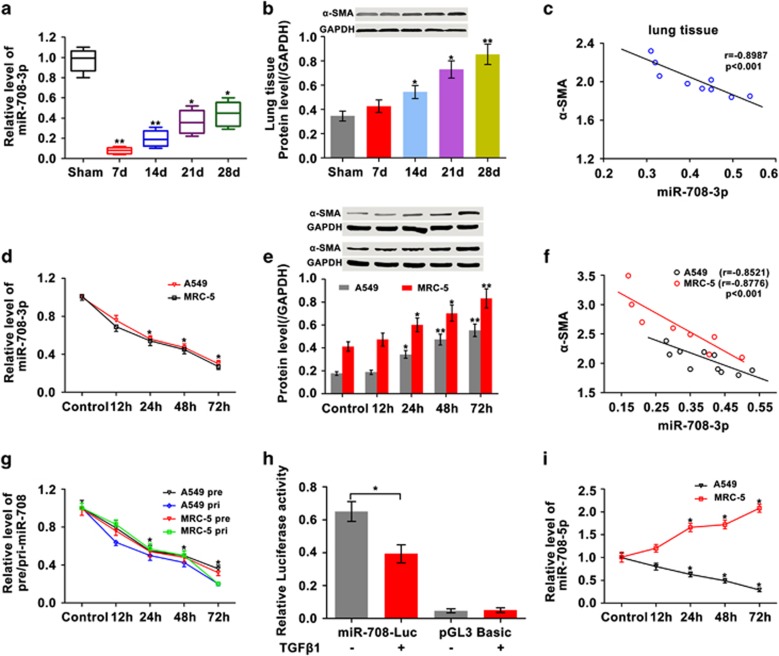
MiR-708-3p expression decreased during fibrosis in vivo and in vitro. (a) MiR-708-3p expression diminished in the lung tissues treated with BLM for 0, 7, 14, 21 and 28 days, as indicated by qRT-PCR. The miR-708-3p expression was normalized to the sham group. (b) α-SMA expression increased in the BLM group relative to that in the sham group. (c) Pearson correlation coefficient clarified that miR-708-3p inversely correlated with α-SMA in vivo. (d) The qRT-PCR results showed that miR-708-3p expression decreased in the TGF-β1-treated A549 and MRC-5 cells. (e) α-SMA increased in the TGF-β1-treated A549 and MRC-5 cells. (f) MiR-708-3p expression levels were inversely correlated with α-SMA in vitro. (g) The qRT-PCR results showed that pri-miR-708 and pre-miR-708 expression decreased in the TGF-β1-treated A549 and MRC-5 cells. (h) MiR-708 promoter activity decreased in A549 cells treated with TGF-β1 for 72 h. The pGL3-basic indicates the negative control. (i) MiR-708-5p expression decreased in A549 cells and increased in MRC-5 cells treated with TGF-β1. Each bar represents the mean±s.d.; n=6. *P<0.05, **P<0.01.